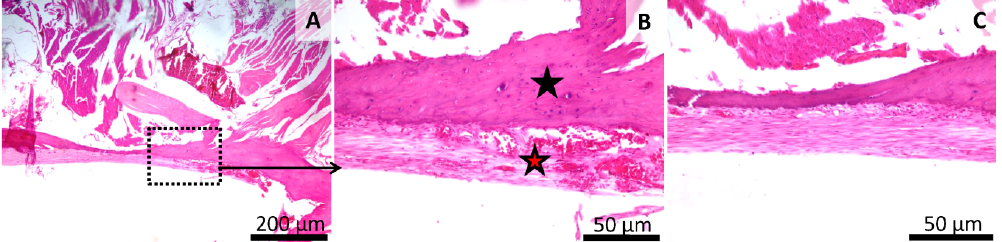
Figure 8. Histology of the mandibular defect. Sham-surgery group (Group 2), irregular aspect of the bone surface (black star) ( A , B ), thin layer of granulation tissue on the bone surface rich in blood vessels and fibroblasts (red star) ( A , B , C ). HE stain, Scale bar = 200 μm ( A ), Scale bar = 50 μm ( B , C ). Materials 2020 , 13 , x FOR PEER REVIEW